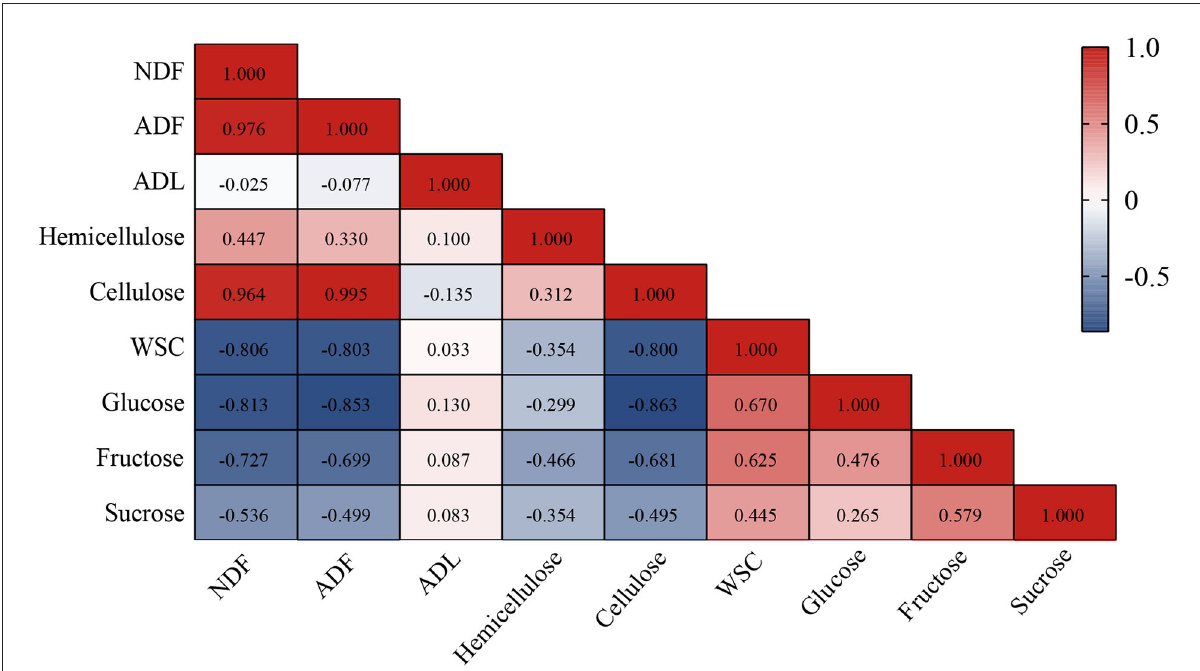
FIGURE2 The Spearman’s correlation analysis between lignocellulose (including NDF, ADF, ADL, hemicellulose, and cellulose) and fermentable carbohydrates (including WSC, glucose, fructose, and sucrose) of hybrid elephant grass ensiled at 60 days. NDF, neutral detergent fiber; ADF, acid detergent fiber; ADL, acid detergent lignin; WSC, water-soluble